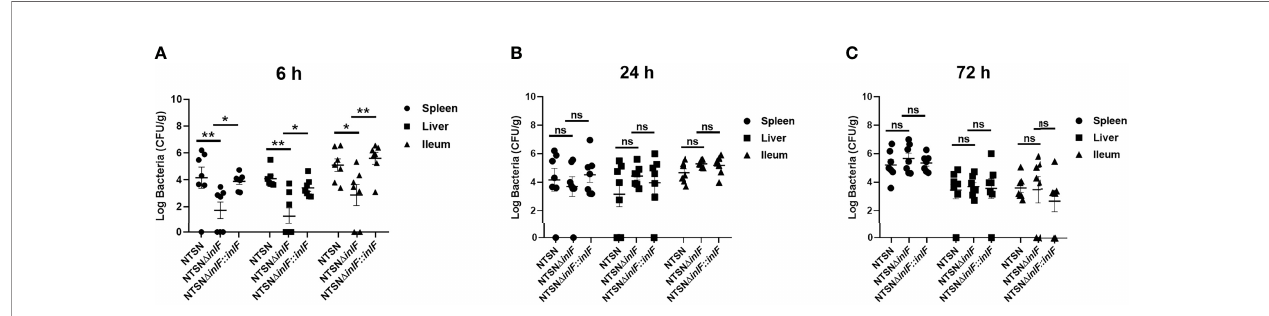
FIGURE 5 | InlF contributes to Lm infection during murine listeriosis. Lm (1 × 10 9 CFU) were intragastrically inoculated to mice (n = 7). Animals were euthanized 6 h (A) , 24 h (B) , and 72 h (C) after infection. The spleen, liver and ileum were recovered, homogenized and plated on BHI or MOX plates. The numbers of bacterium able to colonize the organs are shown. Among them, the PBS negative control group is represented by horizontal line bar, NTSN is represented by black and white check bar and the mutant is represented by black dot bar. Values are mean ± SEM; n = 3 independent experiments. Statistical analysis was carried out by Tukey ’ s